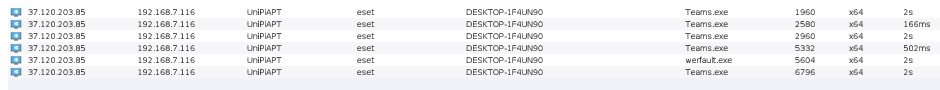
Figure 10. Bypassing ESET PROTECT Enterprise with the EXE and DLL